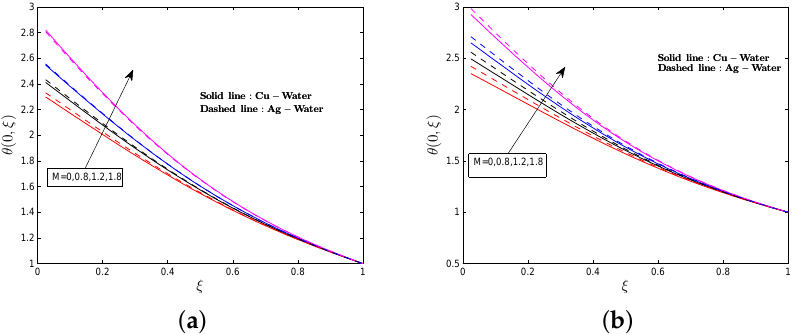
Figure 20. Surface temperature for various values of M . ( a ) vertical plate; ( b ) horizontal